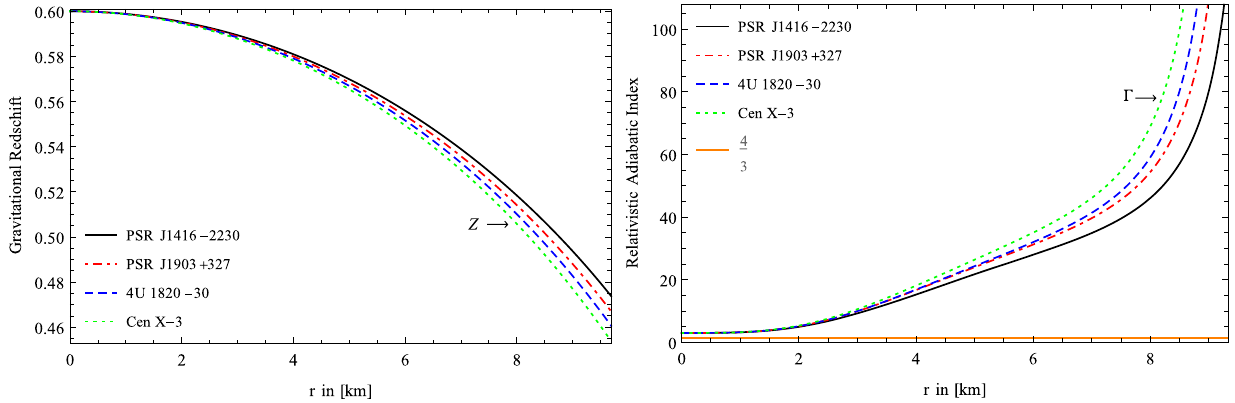
Fig. 6 The variation of gravitational red-shift function (left panel) and relativistic adiabatic index (right panel) with the radial coordinate r for experimental statistics of four different compact stars. For plot-